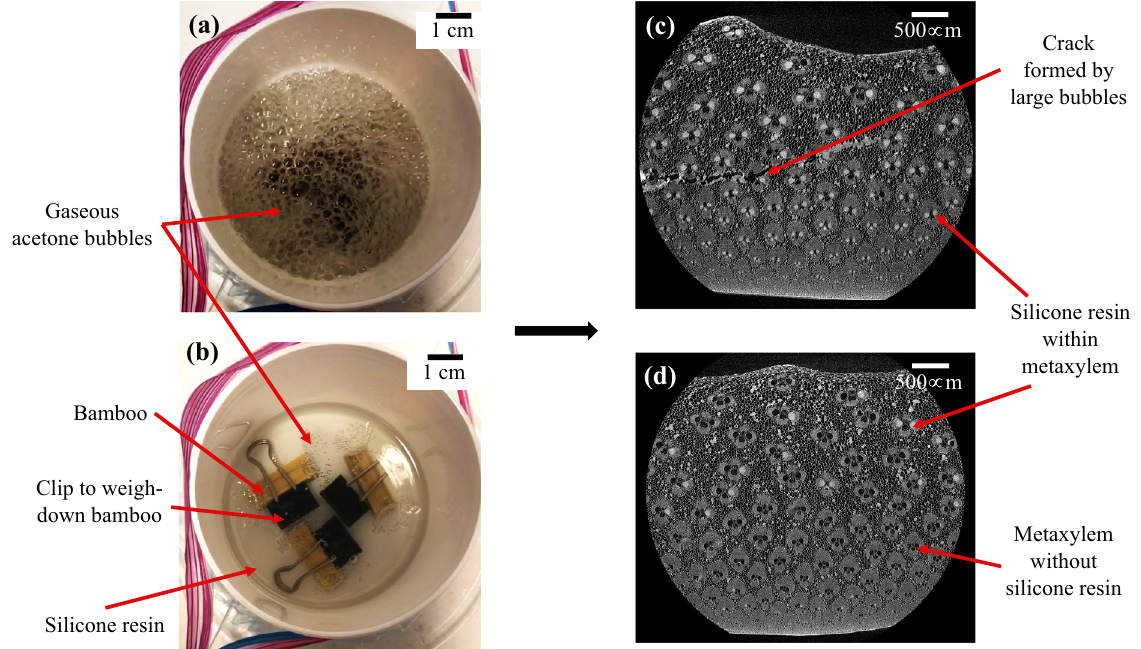
Figure 3. Acetone boiling away from within the bamboo specimens during forced polymer impregnation at ( a ) high vacuum pressure and ( b ) low vacuum pressure. Micro-CT images showing ( c ) a crack in a bamboo specimen due to large bubbles and ( d ) only some of the metaxylem filled with silicone after incomplete forced polymer